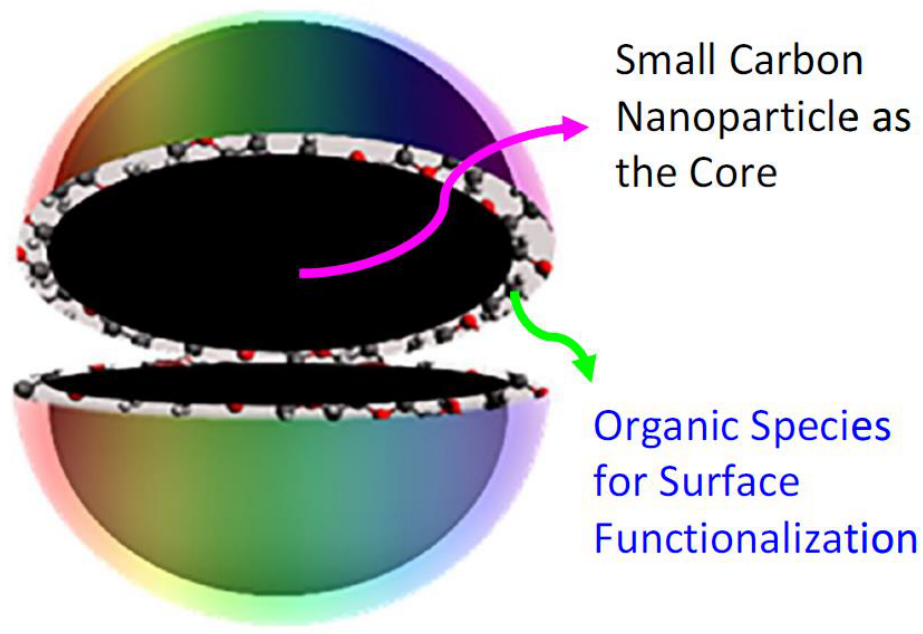
Figure 1. Cartoon illustration on the classically defined CDots obtained from the deliberate chemical functionalization of pre-existing small carbon nanoparticles.